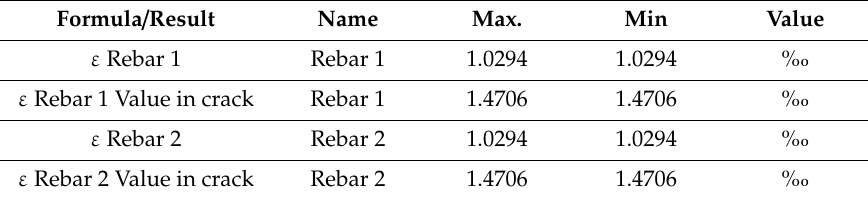
Table 10. Deformation of the rebars 1 and 2 for a moment of 127.88 mkN by FAGUS.